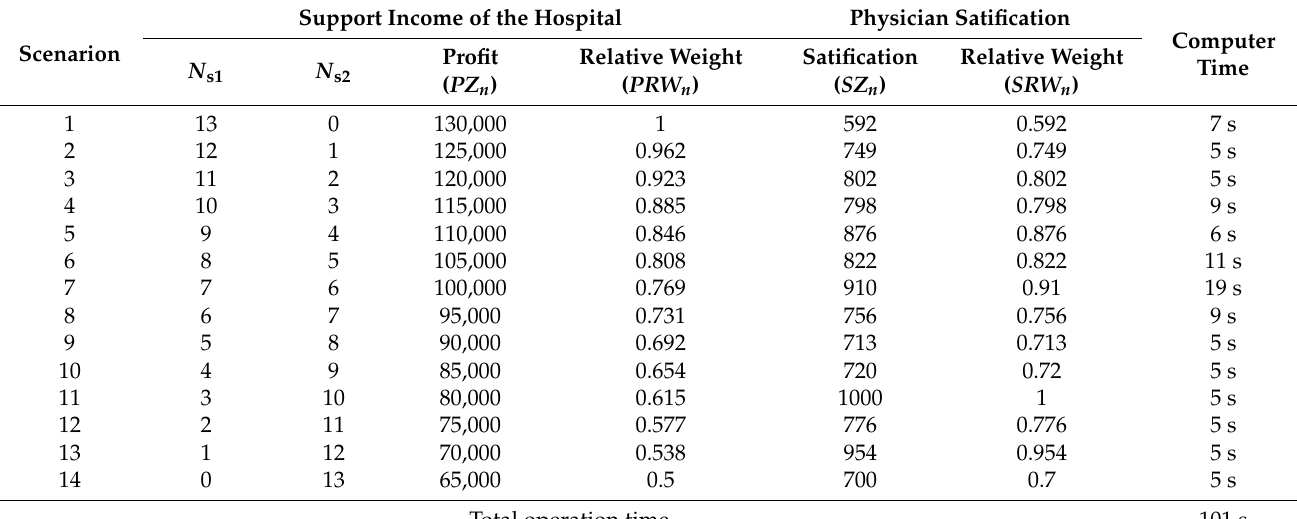
Table 3. Relative weight of each scheduling